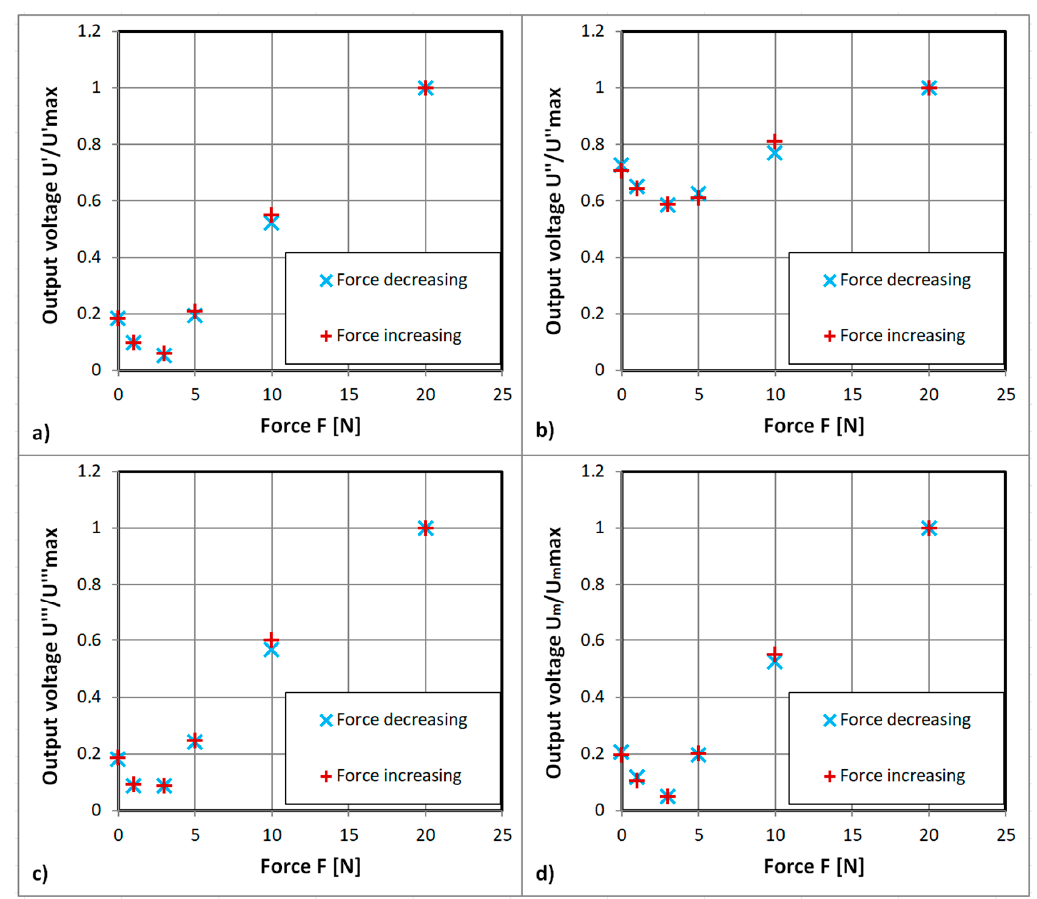
Figure 8. Obtained experimental characteristic of developed ‘straight’ sensor: ( a ) Normalized first